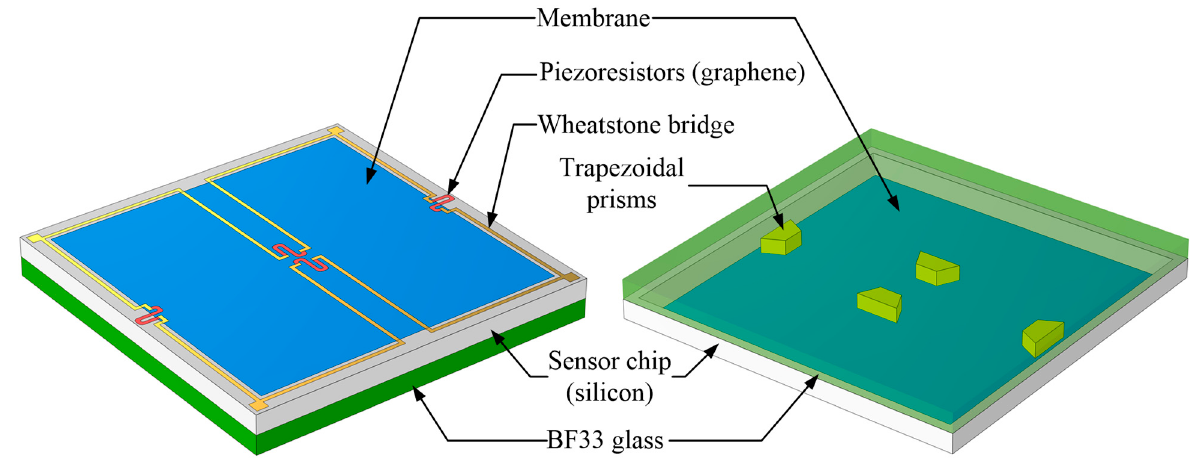
Figure 1. The 3D structure of the proposed pressure sensor.